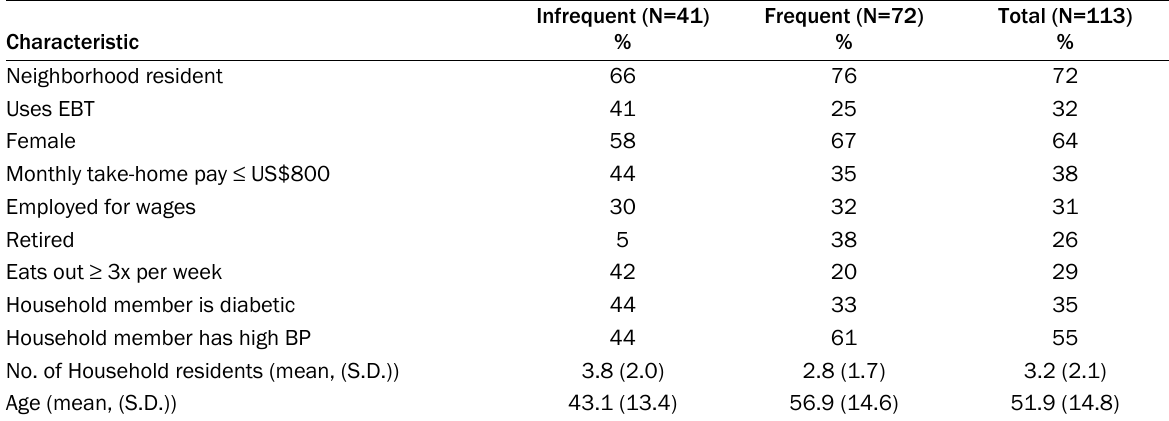
Table 1. Characteristics of Frequent ( ≥ 2x visits per month) and Less Frequent Market Attendees